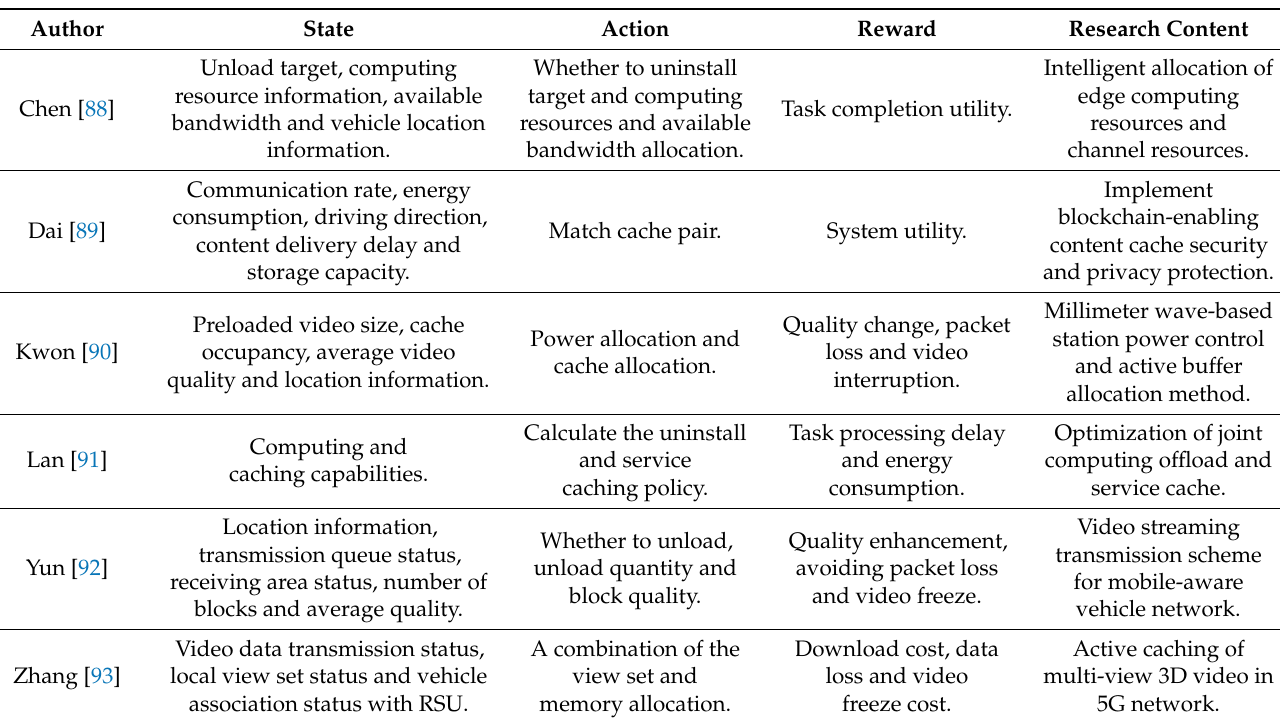
Table 1. Video application methods over CVIS based on